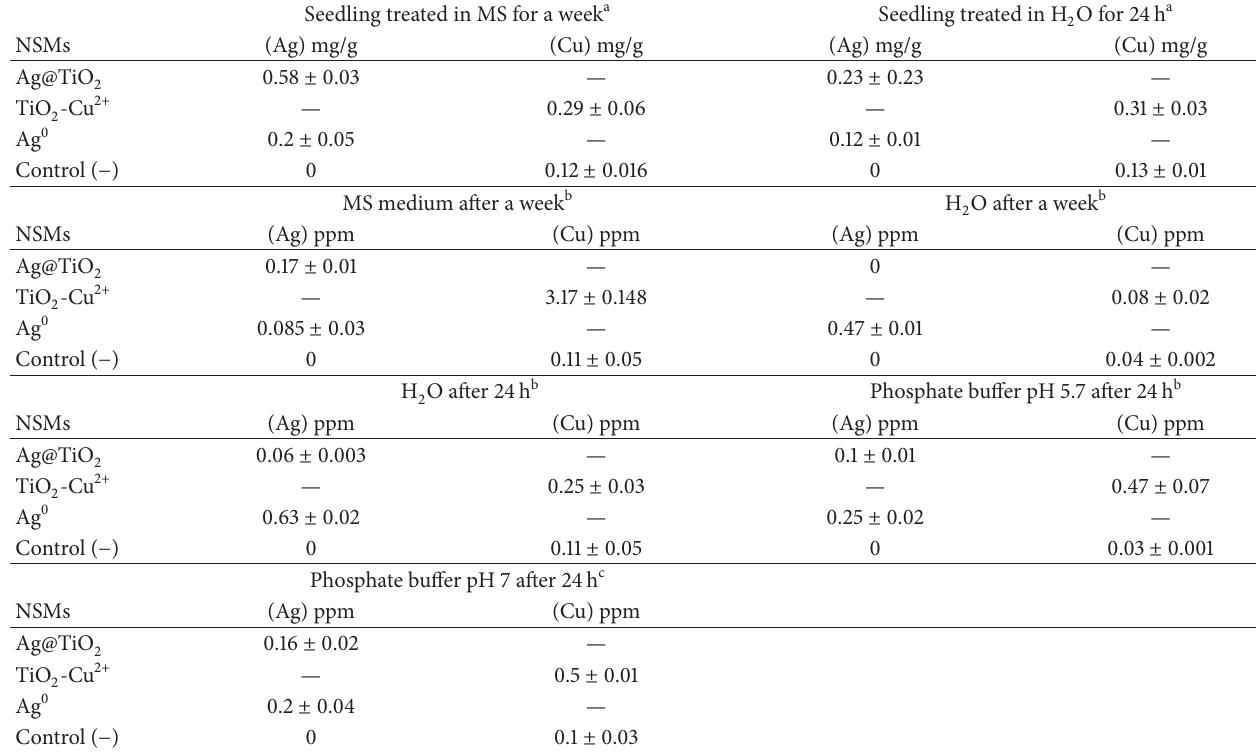
Table 2: Determination of copper and silver by atomic absorption spectrophotometry.